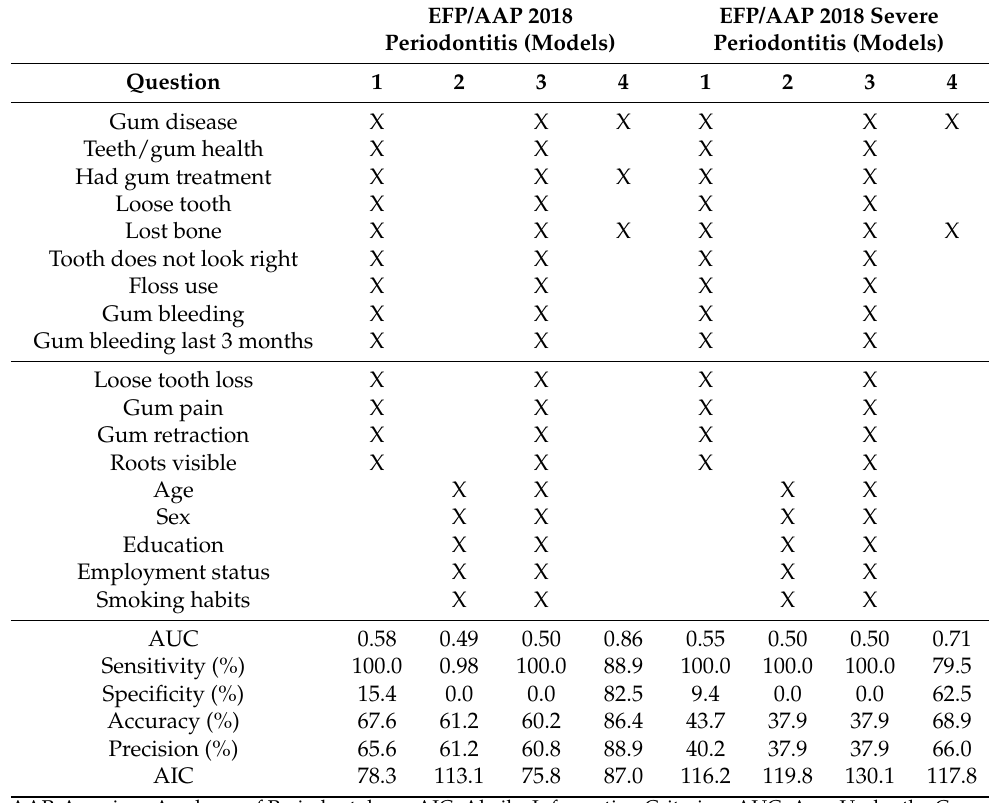
Table 4. Logistic regression models for the periodontitis EFP/AAP case definition of 2018 and respective performance